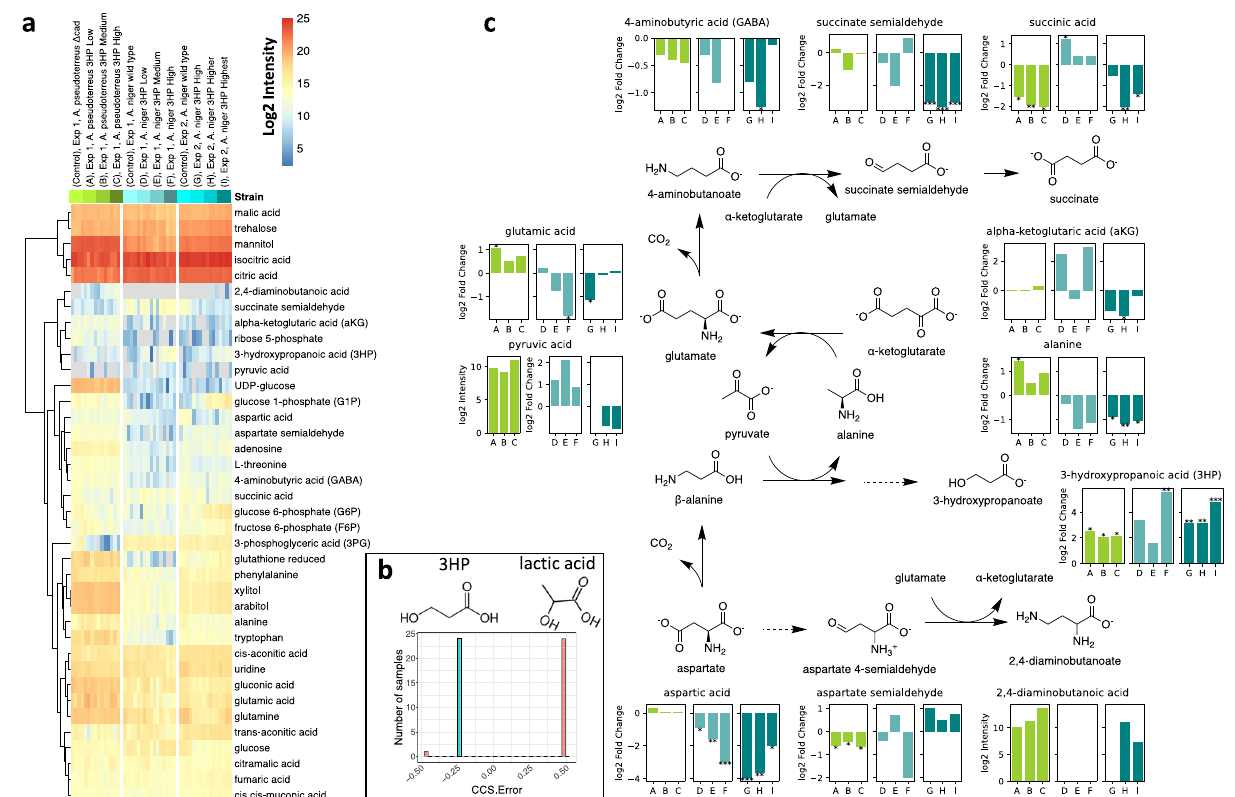
Fig. 5 | Metabolomics pro fi ling of 3HP-producing A. pseudoterreus and A. niger strains. a Relative and label-free intracellular metabolites levels quanti fi ed by PeakDecoder( n =46).Red,yellow,and blue colorsindicatehigh,medium, and low log2 intensity values, and gray color indicates missing values. b CCS errors of the good-quality features in 24 samples con fi rmed the detection of 3HP (green bar, 113.8 CCS) instead of lactic acid (orange bar, 113.0 CCS), which is an isomeric molecule (same formula but with different 3D structure). c Metabolites in the 3HP